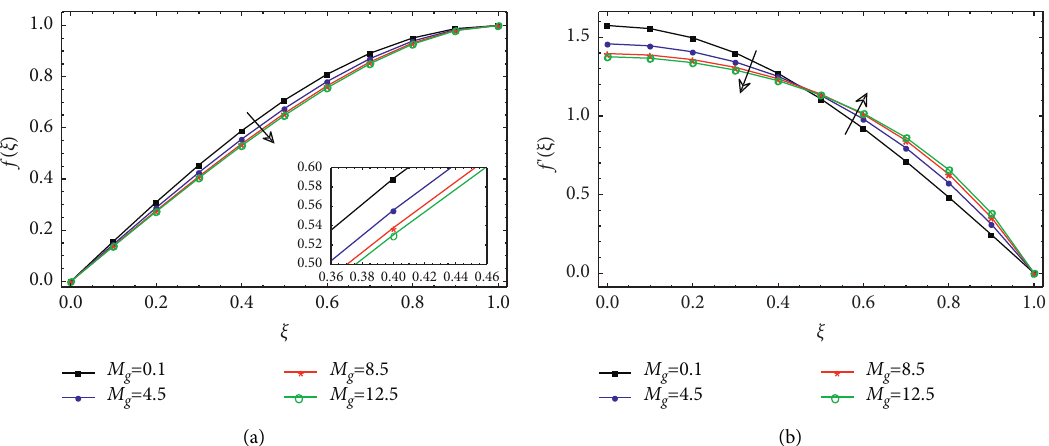
Figure 7: Effect of M g on the velocity profile keeping component of velocity.